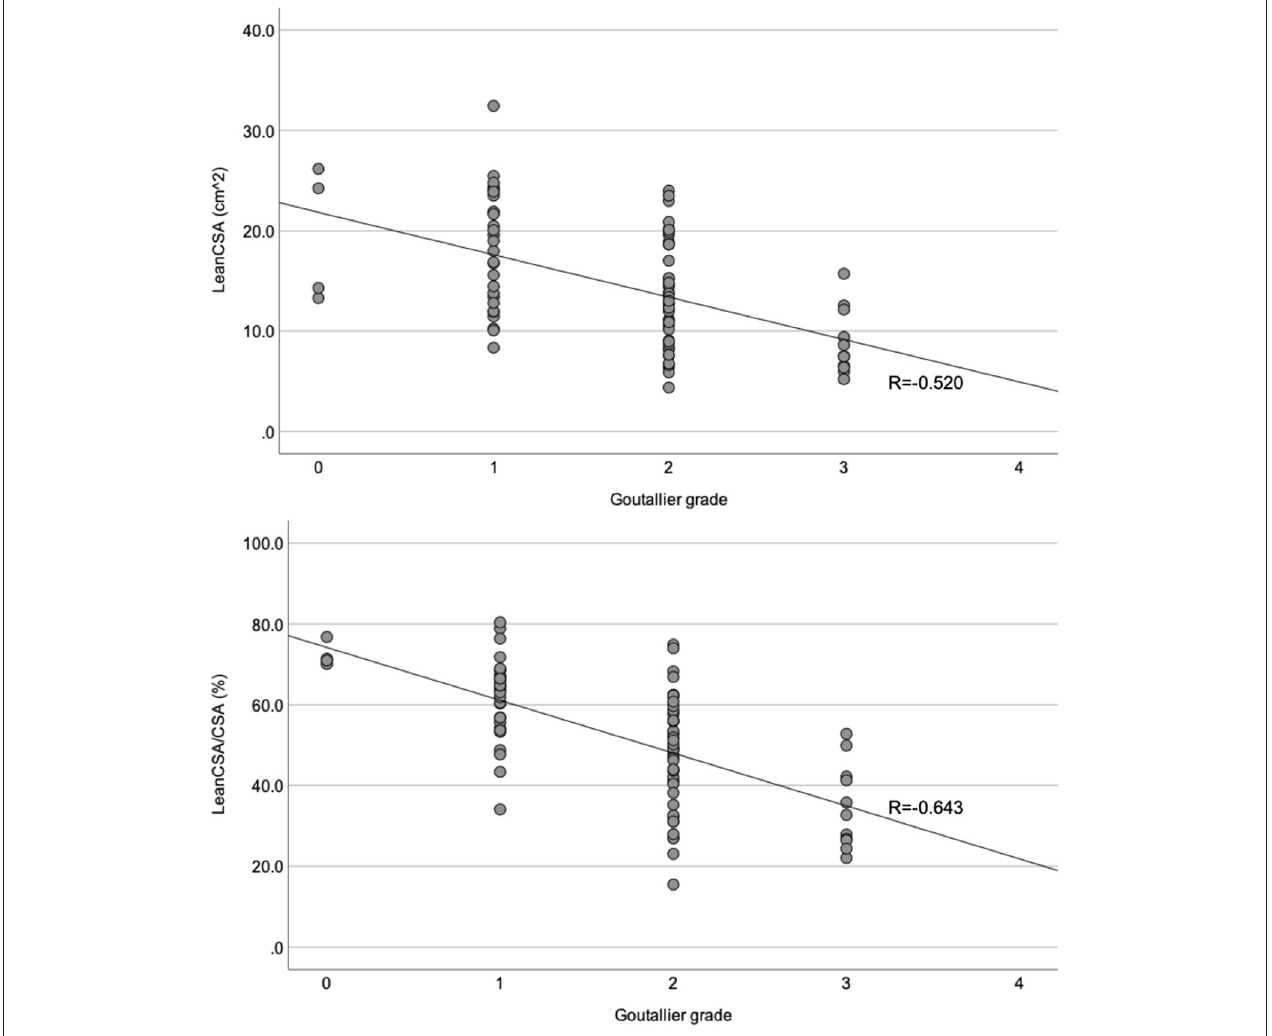
FIGURE 5 | Scatter plots comparing the Goutallier grade for the paraspinal muscles with the lean muscle cross-sectional area (LeanCSA; top) and the ratio between LeanCSA and paraspinal muscle cross-sectional area (LeanCSA/CSA; bottom) of the left side. R , Spearman’s correlation